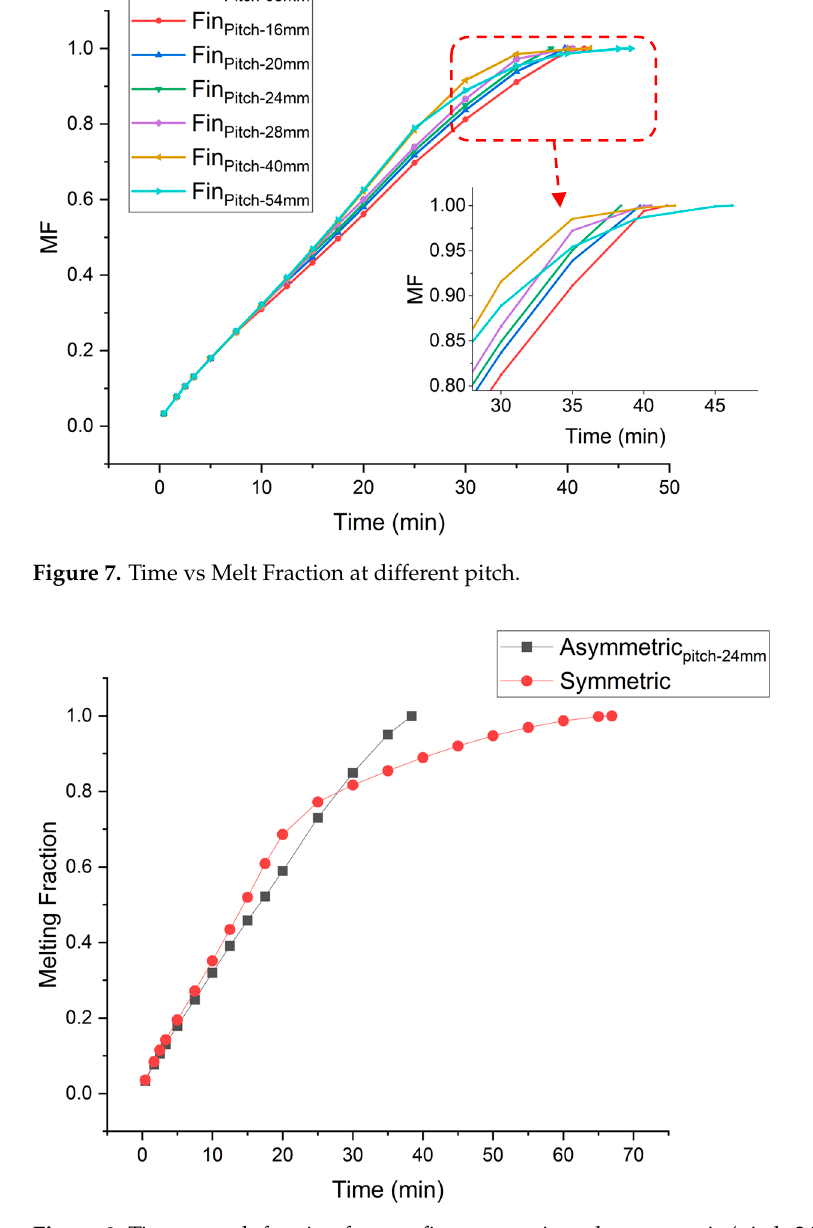
Figure 8. Time vs melt fraction for two fin symmetric and asymmetric (pitch-24 mm).